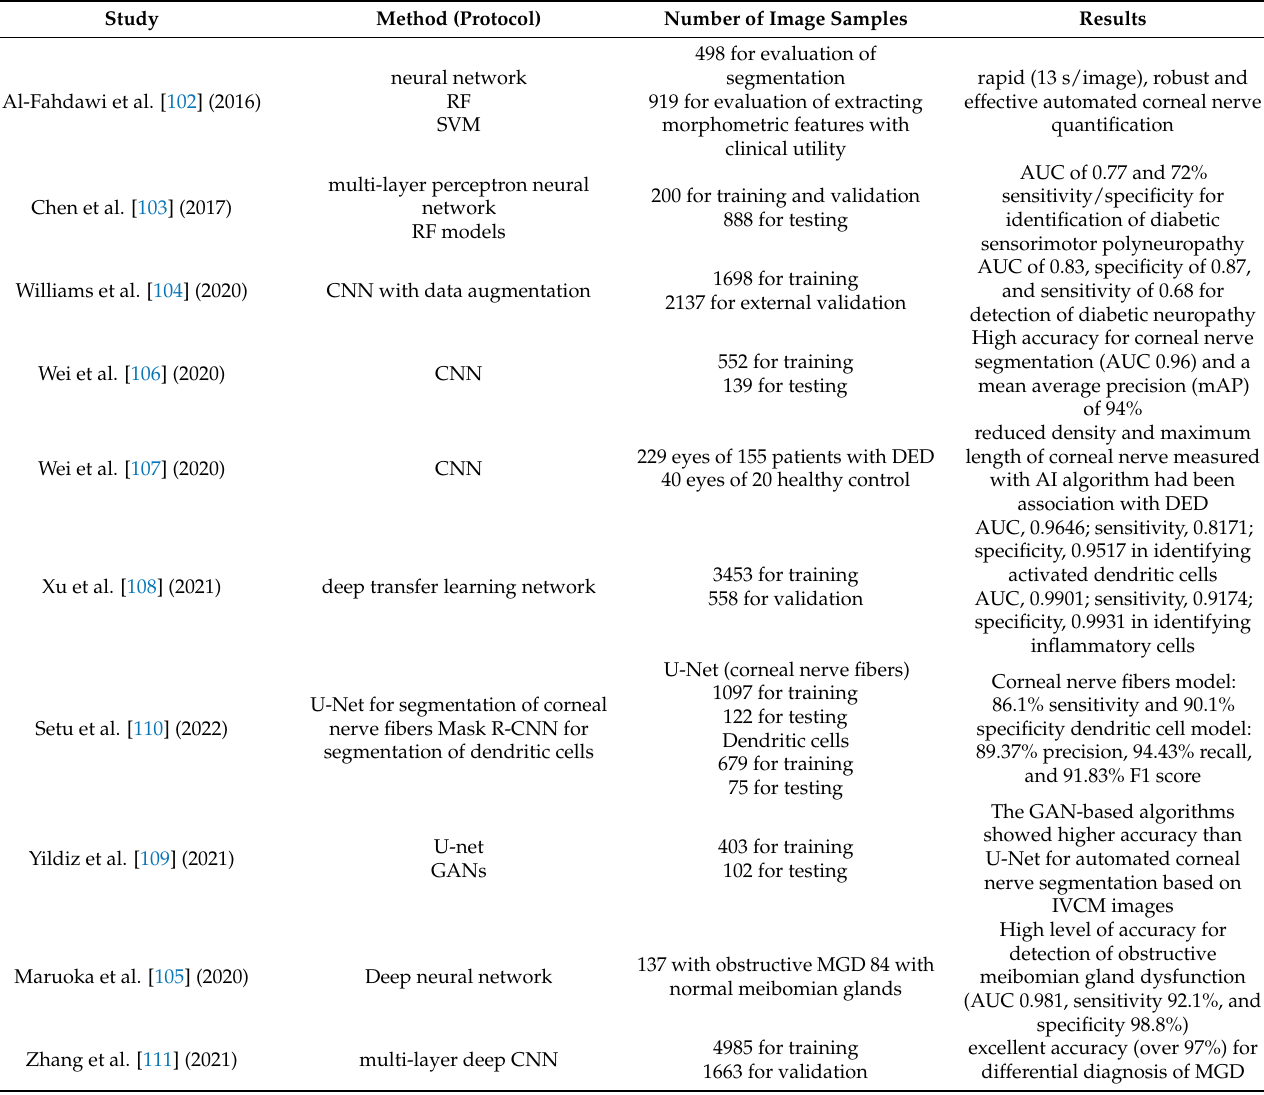
Table 3. Summary of the studies regarding application of AI for analysis of IVCM